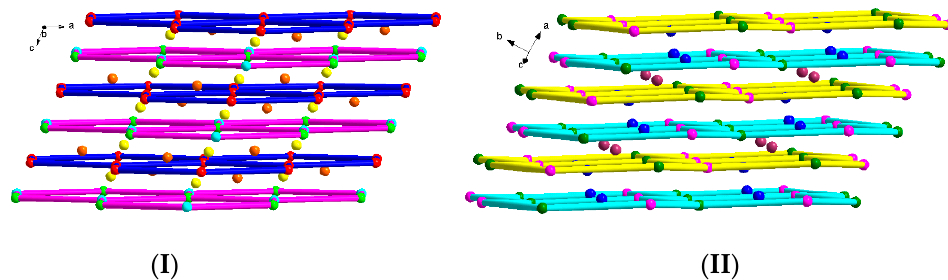
Figure 3. ( I ) Two-dimensional hydrogen-bonded sheets along the b axis in compound ( 1 ); ( II ) Two-dimensional hydrogen-bonded sheets along the c axis in compound ( 2 ).